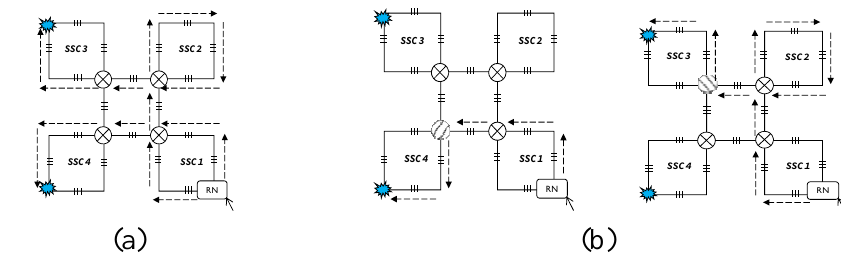
Figure 6. (a) Dual-link failures; (b) Self-healing for dual-link failures.